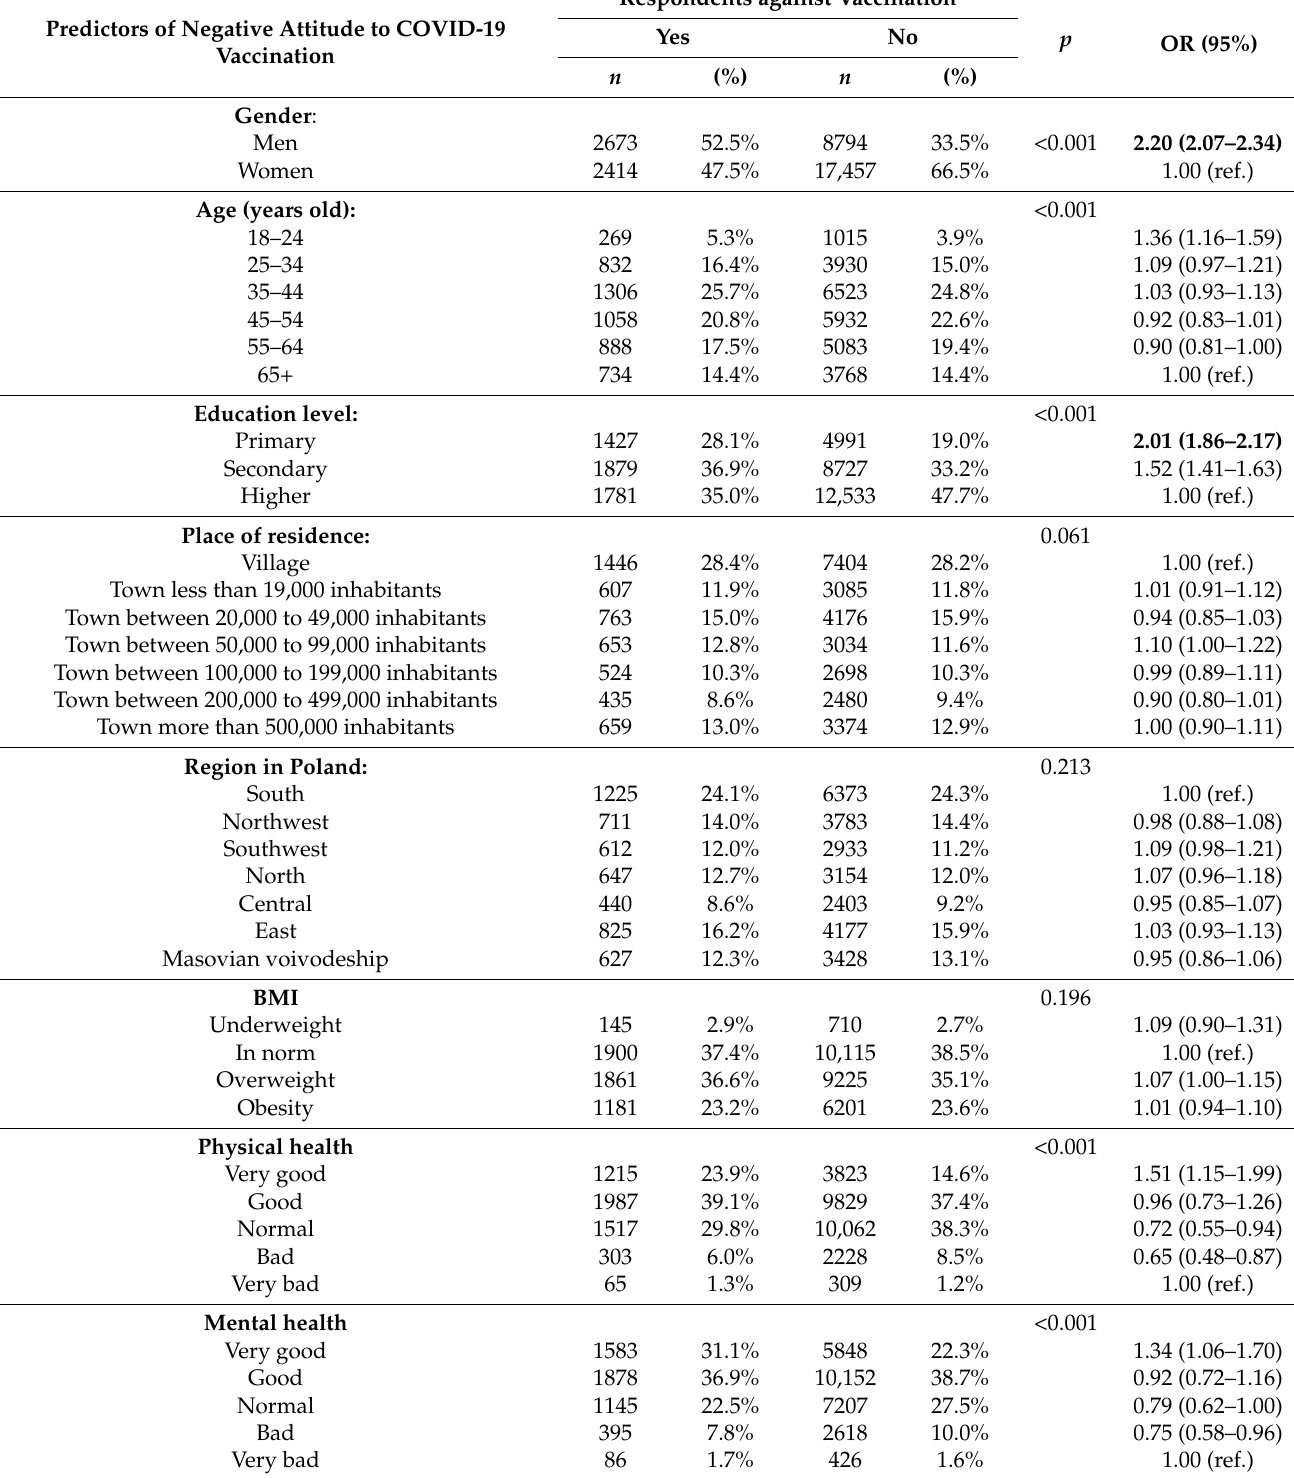
Table 4. Evaluation of negative approaches toward COVID-19 vaccination among studied respon- dents characterizing different sociodemographic factors (odd ratios higher than 2 were